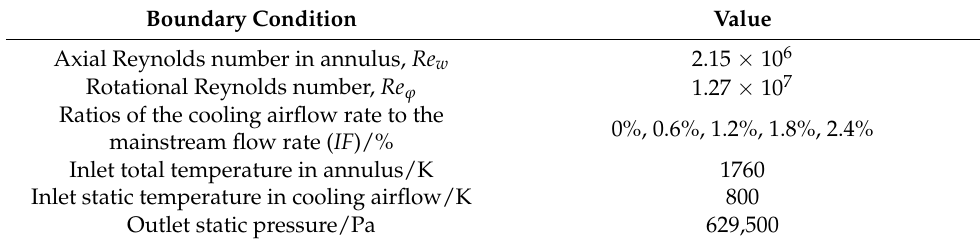
Table 1. Boundary conditions.